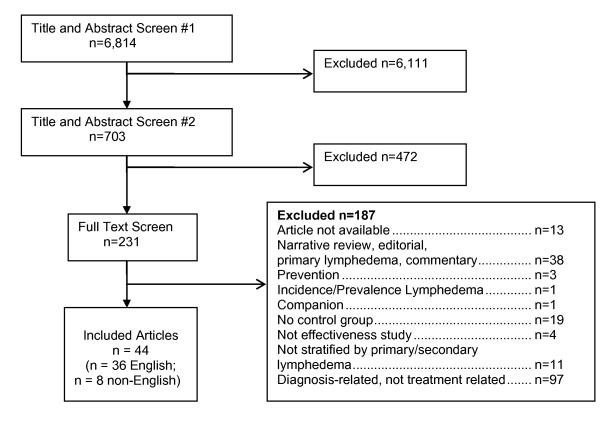
Study flow diagram.